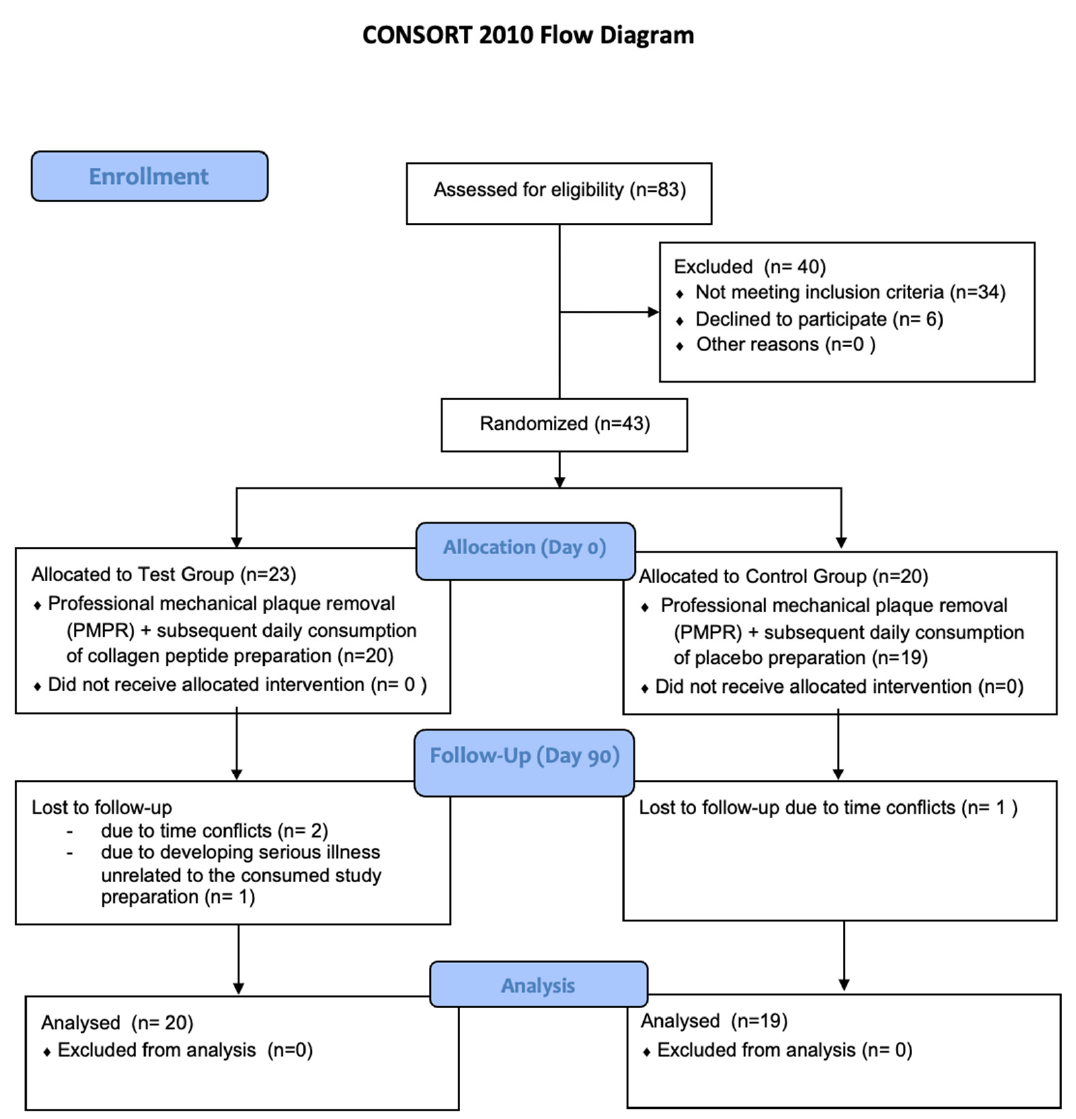
Figure 1. Recruitment, drop-outs and protocol violations during the study observation period.